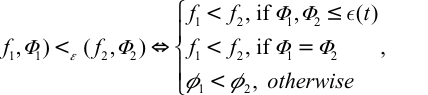
: R d → R is the j-th equality j falls into the range [l i